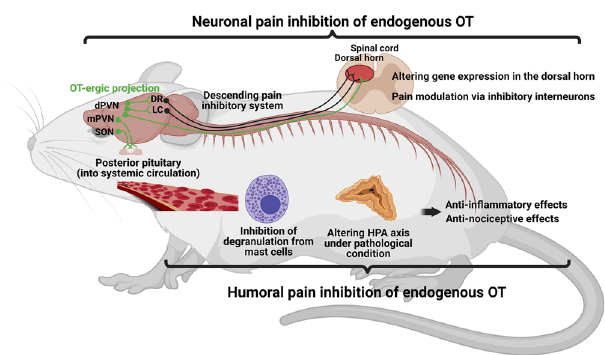
Fig. 10 The putative mechanism of endogenous OT on pain modulation. A model describing the putative mechanism of endogenous OT on pain modulation is illustrated schematically. Central OT may exert anti-analgesic effects both directly and indirectly via descending inhibitory system. On the other hand, peripheral OT may alleviate in fl ammatory response by inhibiting degranulation from mast cells and by modulating HPA axis under pathological condition, resulting in hindering pain transmission. Created with